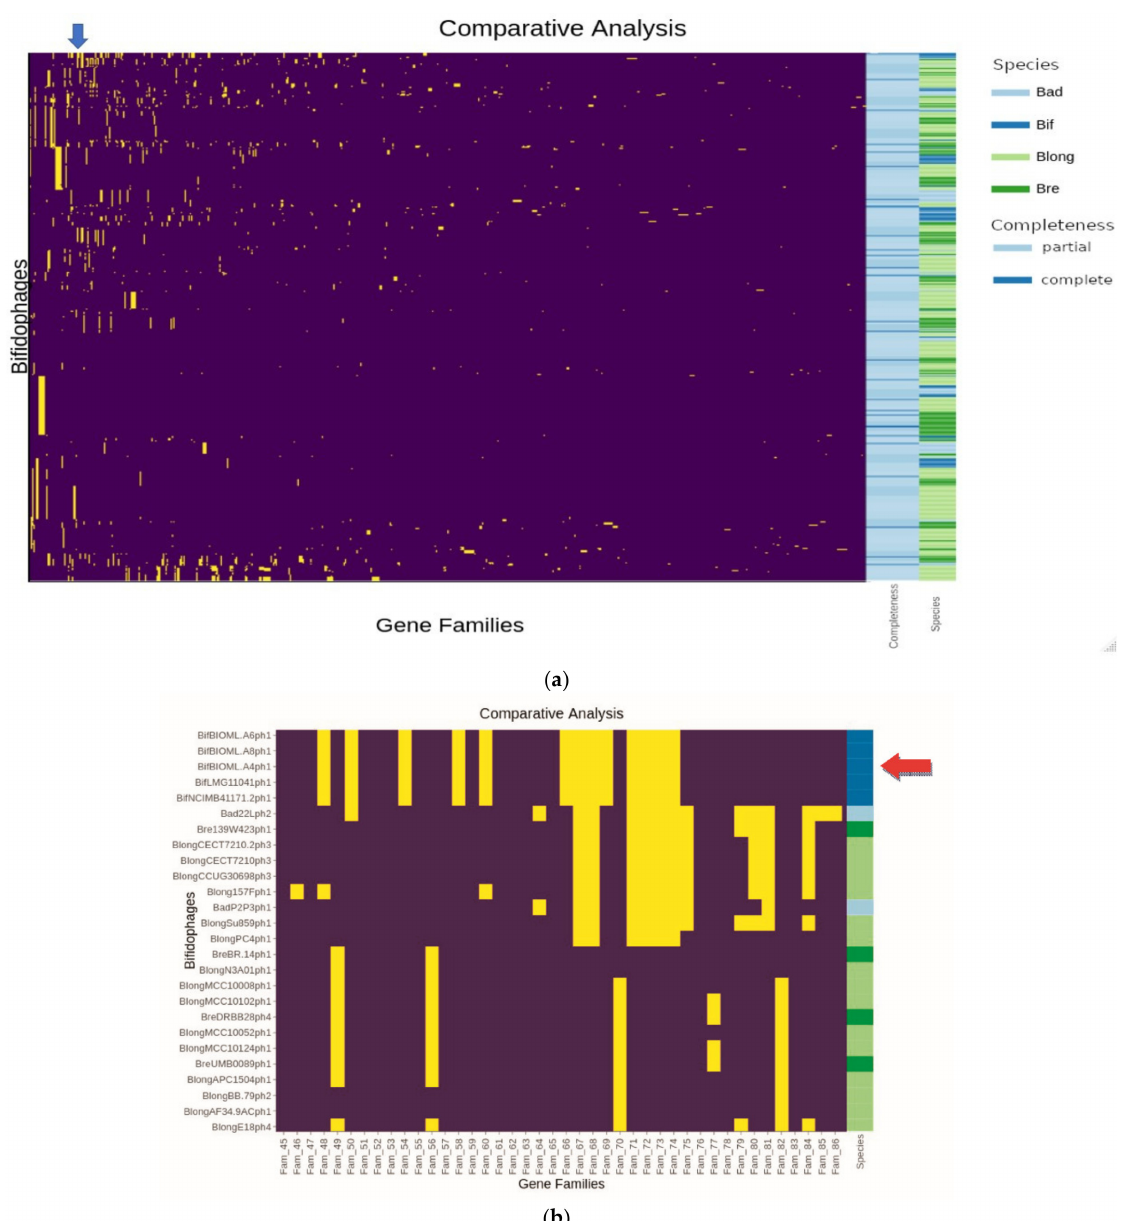
Figure 3. ( a ) Comparative Analysis heatmap produced by heatmaply. Gene families are presented on the horizontal axis, while bifidophages are presented on the vertical axis. We used a binary yes/no 100% gene similarity cut off. Gene familie that are present are represented by a yellow cell, while purple indicates gene absence. Specifically, yellow cells on the same vertical line indicate a gene family present in multiple bifidophages, while yellow cells on the same horizontal line indicates multiple gene families present in a single bifidophage. The rowside legends indicates which species of bidifobacteria the phage belongs to and the degree of completeness predicted by PHASTER. B. longum is represented in pale green, B. breve in dark green, B. adolescentis in pale blue, and B. bifidum in dark blue. As previous, bifidophages predicted to be likely complete or complete are highlighted in dark blue and suspected partial or likely remnant bifidophages are highlighted in light blue. A blue arrow highlights an example of a cluster of multiple genes shared between the same Bifidobacterium bifidum strains highlighted in Figure 2. A red arrow indicates an example of gene families from a bifidophage shared across multiple Bifidobacterium species, highlighted in Figure 2. ( b ) Comparative analysis heatmap highlighting the same cluster represented in Figure 2 indicated here by a red arrow. This image is a zoomed-in view of the area highlighted in Figure 3a. Multiple gene families are shared between the B. bifidum phages BifBIOML-a4 phage 1, BifBIOML-a6 phage 1, BifBIOML-a8 phage 1, Bif LMG11041 phage 1 and BifNCIMB41171 phage 1. There is also an example of interspecies gene sharing between phages targeting hosts from B. adolescentis , B. breve , and B. longum directly below the bifidum example. Most notably, Bad22L phage 2, Bre139W423 phage 1 and BlongSu859 phage